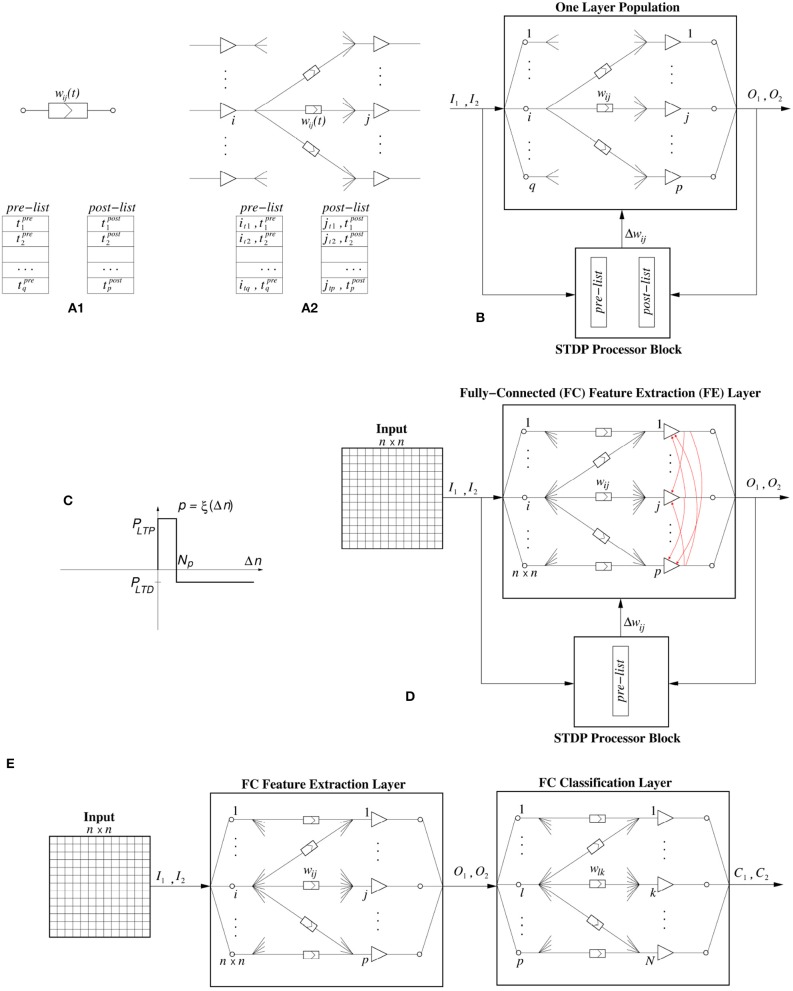
(A) STDP computation. (A1) By keeping a pre- and a post-synaptic event list per synapse, (A2) by keeping a pre- and a post-synaptic event list per neuron population with its input synapses. (B) STDP computation block assigned to a neuron population with its input synapses. (C) Stochastic STDP learning function. (D) The neural network topology used in this work for the fully-connected FE (feature extraction) hidden layer, where p is its size. The red arrows represent the lateral inhibition that is implemented internally. (E) Event-Driven System Topology used in this paper when the experiments require a FE layer and a Classifier layer.